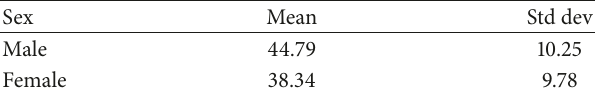
Table 1: Participants age distribution by